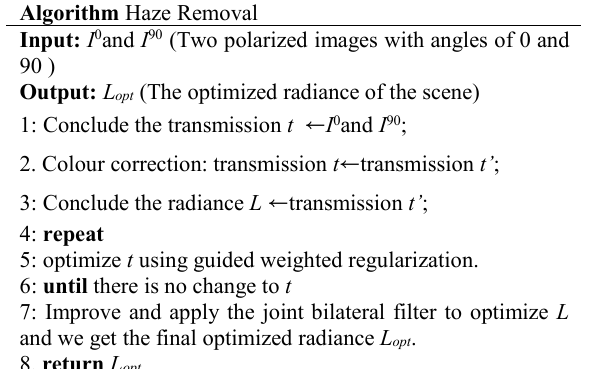
Algorithm Haze Removal